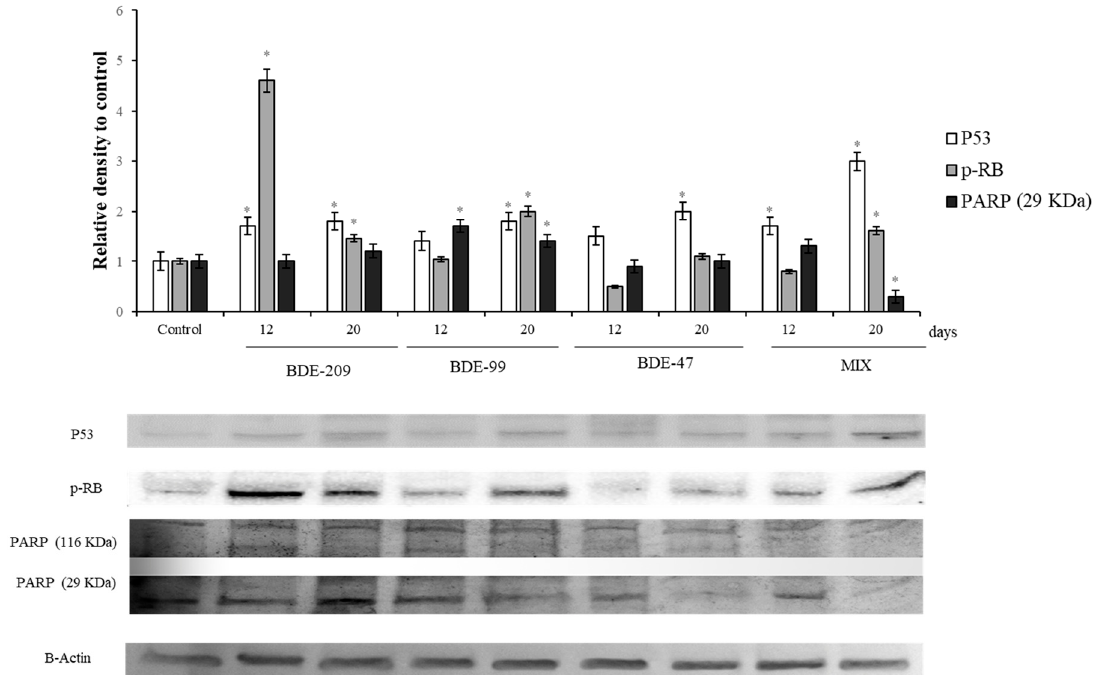
Figure 3. Immunoblotting of p53, pRB, PARP, evaluated on HS-68 cells exposed to 1 µmo/L BDE 209, 99, 47 and MIX for 12 and 20 days. Actin was used as internal control. The images are representative of at least three separate experiments. The relative protein quantification is represented in the graphic (* p < 0.05).